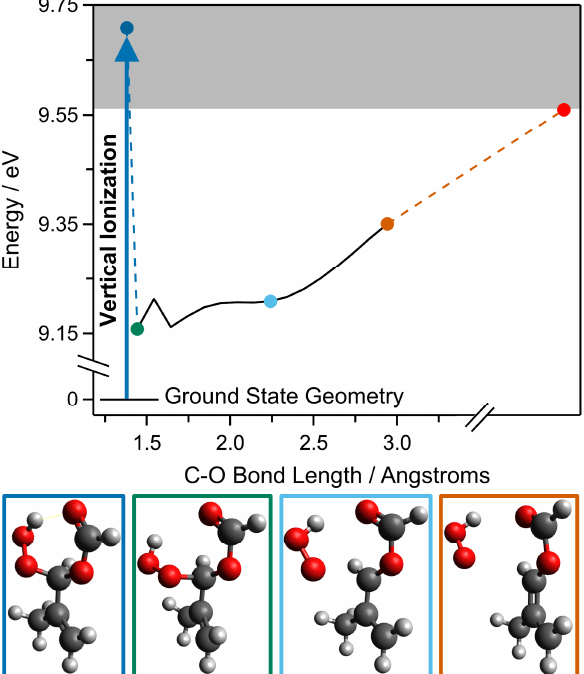
Figure 4. Constrained optimization (ωB97XD/6–31 + G*) of the C–O bond length associated with HO 2 dissociation from the HPMAF ion. Significant points included are: Franck–Condon excitation from the equilibrium geometry of the ground state (dark blue), the adiabatic minimum of the ion state (green), an intermediate point along the HO 2 dissociation coordinate (light blue), separated products in the relaxed optimization (orange), and (red) asymptotic energy for the HO 2 -loss fragment ion. The grey shaded region illustrates that the HO 2 + ion co-fragment asymptote is below the calculated vertical ionization energy, suggesting the photoionization process will result in dissociative ionization.